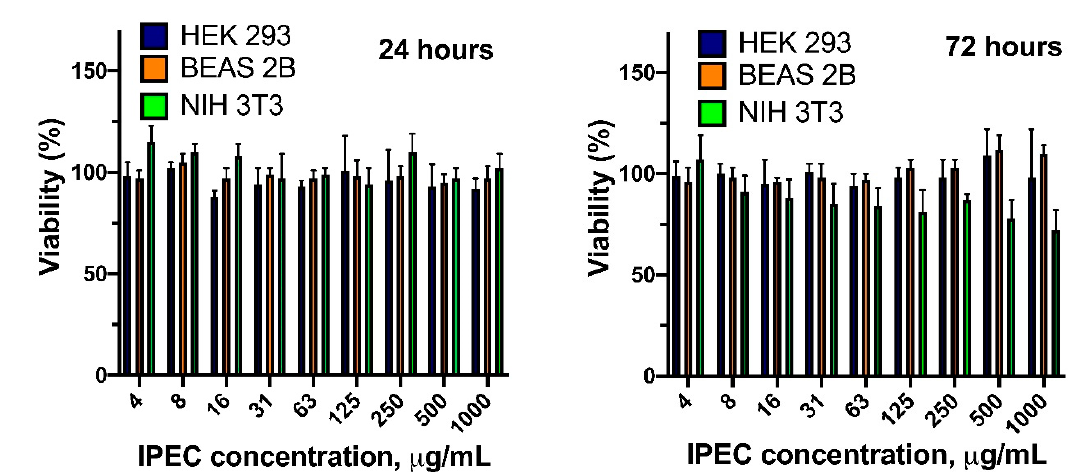
Figure 9. CTB test: viability of HEK 293, BEAS 2B and NIH 3T3 cells incubated with different concentrations of cross-linked IPECs ([Lys–NH 3+ ]:[Hep–SO 3 − ]:[linker] = 1: 3:0.8). Polymers 2020 , 12 , x FOR PEER REVIEW